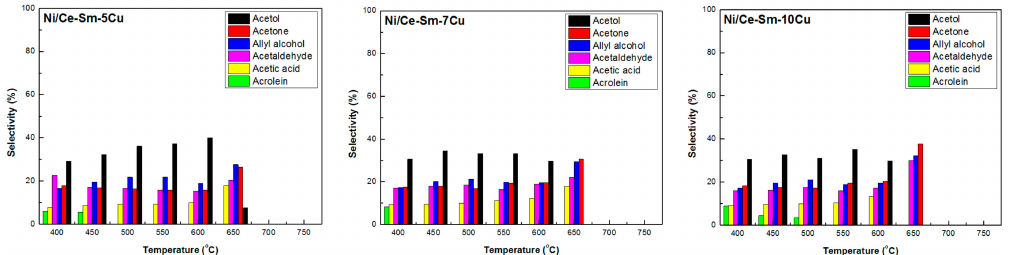
Figure 11. Liquid products selectivity for the Ni/Ce-Sm-xCu (x = 5, 7, and 10 at.%) catalysts [Results obtained for samples tested under experimental protocol